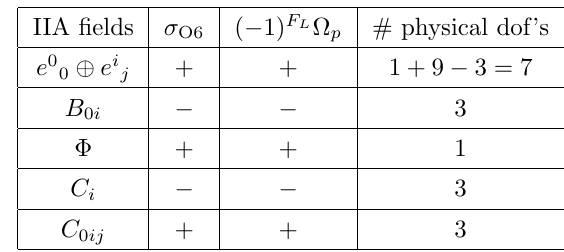
Table 2 . The counting of the total amount of O6 allowed propagating scalar dof’s in type IIA compacti(cid:12)cations down to six dimensions. The complete set of moduli counts 17 dof’s which is exactly the dimension of the supergravity coset given in (3.1). Note that one needs to subtract from e i j the 3 unphysical directions corresponding to SO(3) generators in order to get the correct